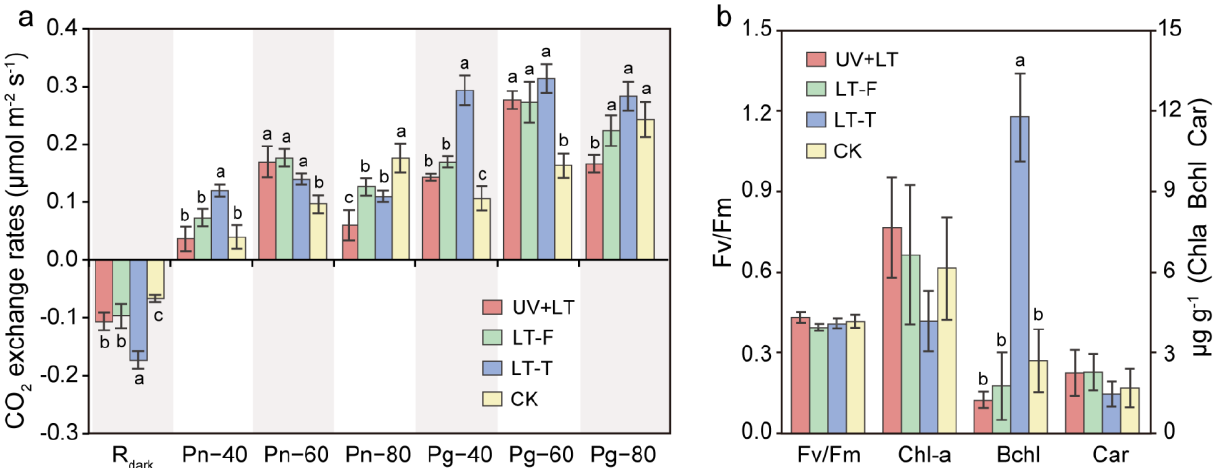
Figure 2. Photosynthetic activity of cyanobacterial crusts. ( a ) The CO 2 exchange rate of cyanobacterial crusts under different light conditions. R dark , the dark respiration rate; Pn −40, Pn− 60, and Pn− 80 represent net photosynthesis rate under the light intensity of 40 μE, 60 μE , and 80 μE, respectively; Pg −40, Pg− 60, and Pg−80 represent gross photosynthesis rate under the light intensity of 40 μE, 60 μE , and 80 μE, respectively. ( b ) Fv/Fm values and content of chlorophyll-a (Chla), bacterial chlorophyll (Bchl), and carotenoids (Car). UV + LT: stratospheric exposure; LT-F: low-temperature freezing; LT-T: low-temperature thawing; CK: natural control. Error bars show mean ± SD and different lowercase letters indicate significant difference (Tukey HSD; p < 0.05) between treatments and control ( n = 3).